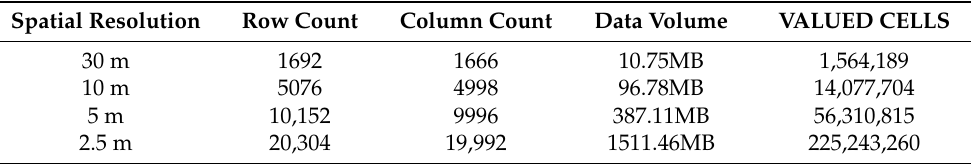
Table 3. The datasets volume and row/column count for the DEM.